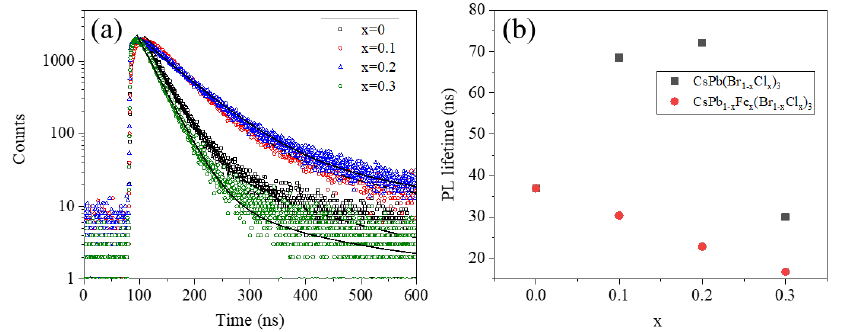
Figure 5. ( a ) Time-resolved PL spectra of the CsPb 1 − x Fe x (Br 1 − x Cl x ) 3 ; ( b ) PL lifetime parameters of the CsPb 1 − x Fe x (Br 1 − x Cl x ) 3 obtained from numerical fitting on ( a ). PL lifetimes of the CsPb(Br 1 − x Cl x ) 3 are also plotted for comparison.